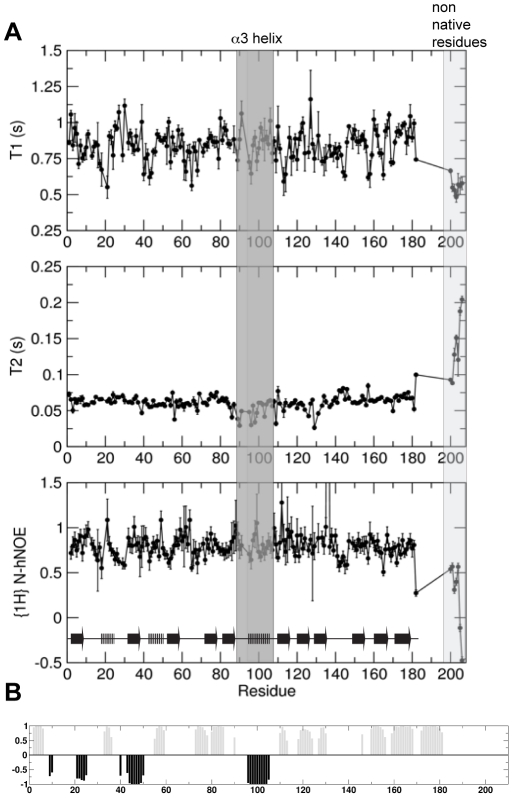

15N NMR relaxation data for VPS29 indicates a generally rigid structure with no large-scale mobility with well defined secondary structural elements.(A) Longitudinal T1 and transverse T2 relaxation times as well as the {1H}15N heteronuclear NOEs are shown as a function of protein sequence. Residues within helix α3 are highlighted in grey. Six N-terminal (non-native) resides are shown and are labelled as residues 201–206. The protein secondary structure is indicated at the bottom of the figure. Data was recorded using a 600 MHz spectrometer. (B) The TALOS+ artificial neural network (ANN)-predicted secondary structural elements of VPS29. Length of bars corresponds to probability of a residue to be helix (black) or β-strand (grey).